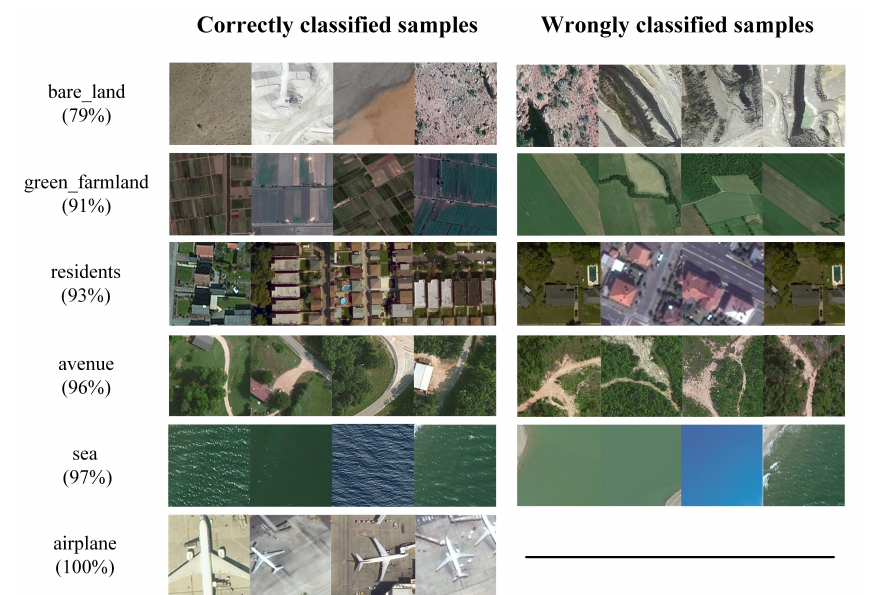
Figure 15. Theclassification results of VGGNet for RSI-CB (the numbers in brackets indicate the precision of classification).